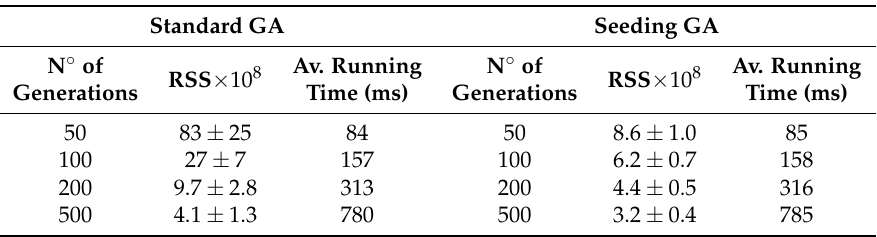
Figure 10. Probability density function of the RSS for the 137 Cs spectrum as a function of the number of iterations for the boosted GA (500 run each). Table 3. Average value and standard deviation of RSS and average running time as a function of the number of iterations (500 run each) for both standard and seeding